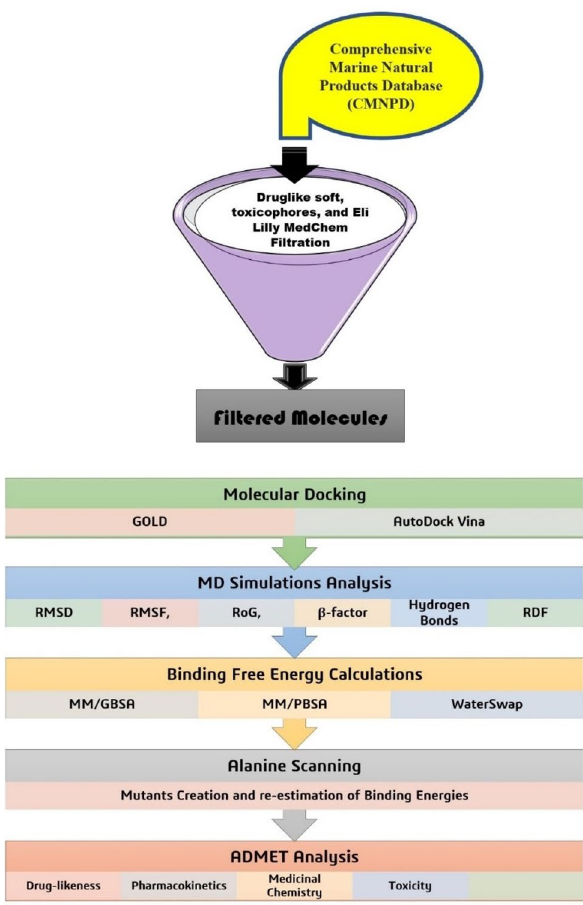
Figure 1. Methodology flowchart to achieved docking, dynamics, and ADMET analysis of virtual screened